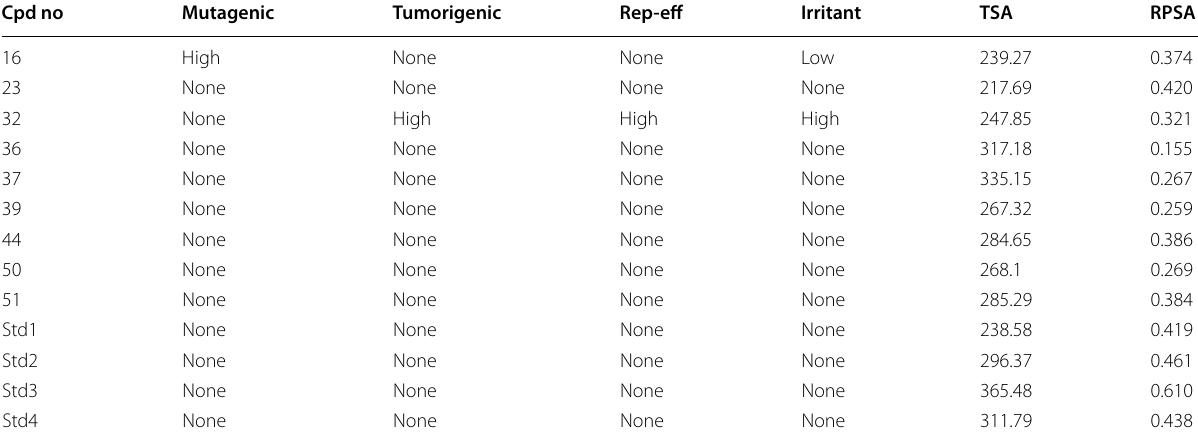
Rep-Eff, reproductive effective; TSA, total surface area; RPSA, relative polar surface area; Std1, ampicillin; Std2, oxytetracycline; Std3, chlortetracycline; Std4,